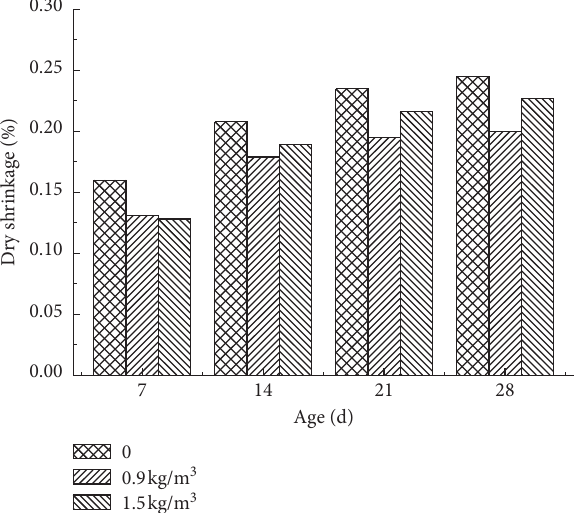
Figure 3: Effect of PP fiber on the dry shrinkage of CGA